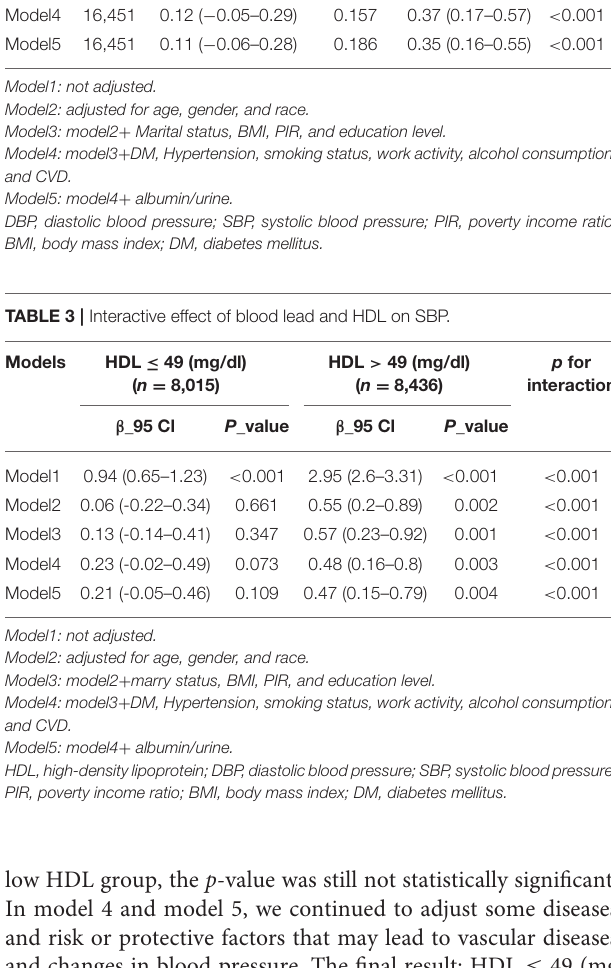
TABLE 2 | Association between blood lead and blood pressure. Models